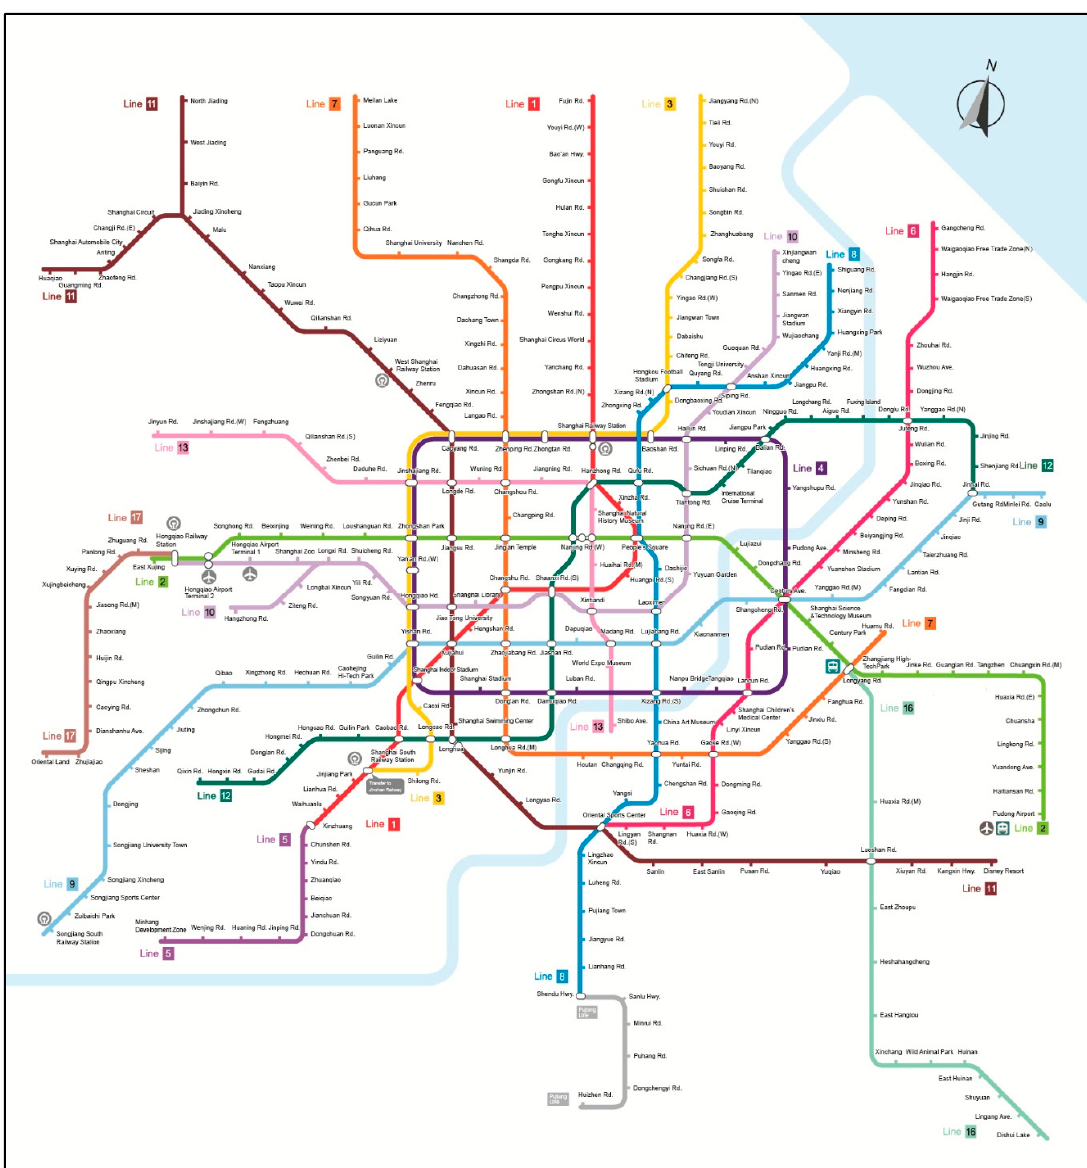
Figure 6. Map of the Shanghai metro [39].